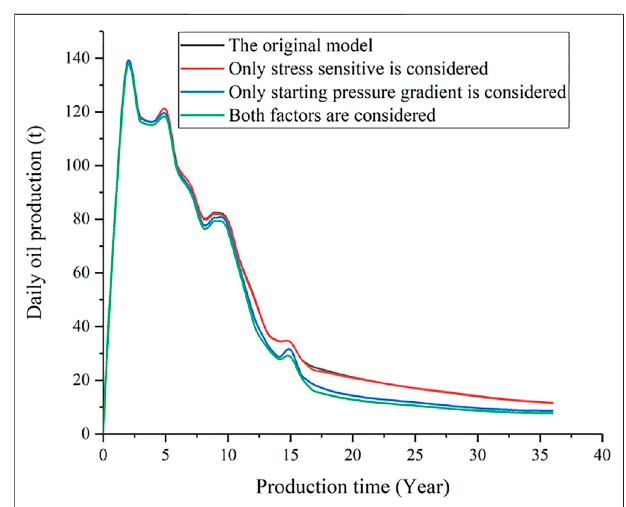
FIGURE 12 | Recovery degree of the Chang 6 reservoir considering different stress factors.